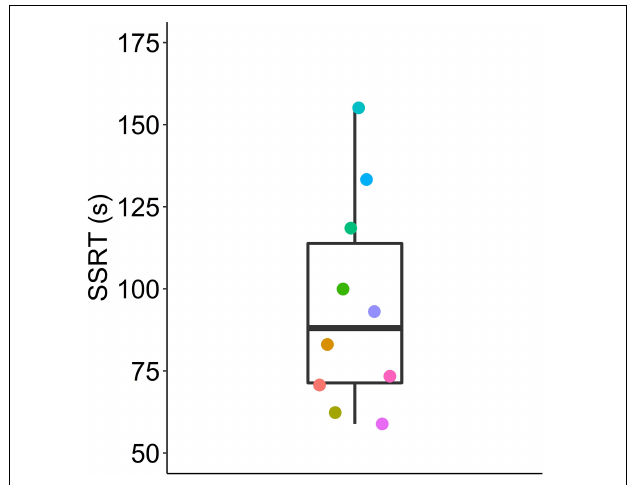
FIGURE 7 | Stop signal reaction times (SSRTs) calculated from pooled data using the two horse race model. Box plot shows median, 1st and 3rd quartile, and whiskers the 1.5 interquartile range. Data from n = 10